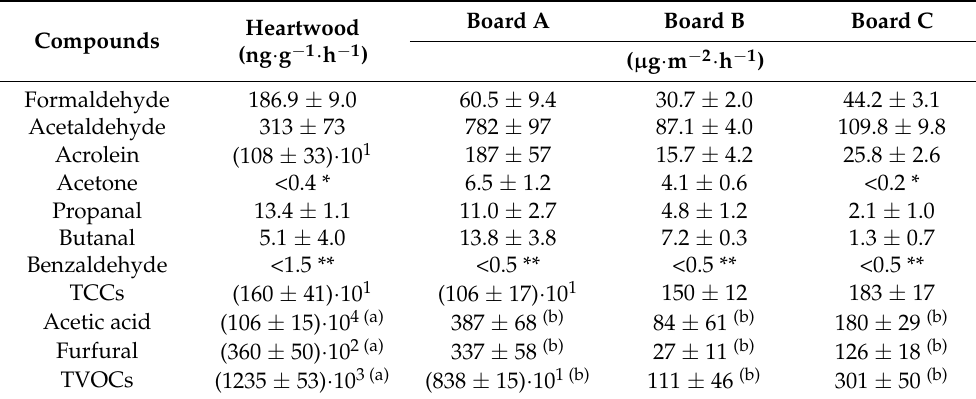
Table 4. SERs from the raw material and the binderless boards.